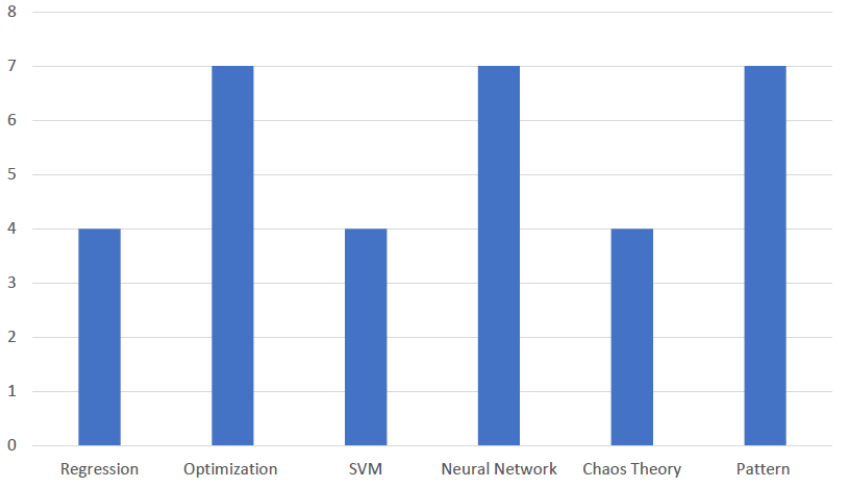
Figure 8. Popularity of the